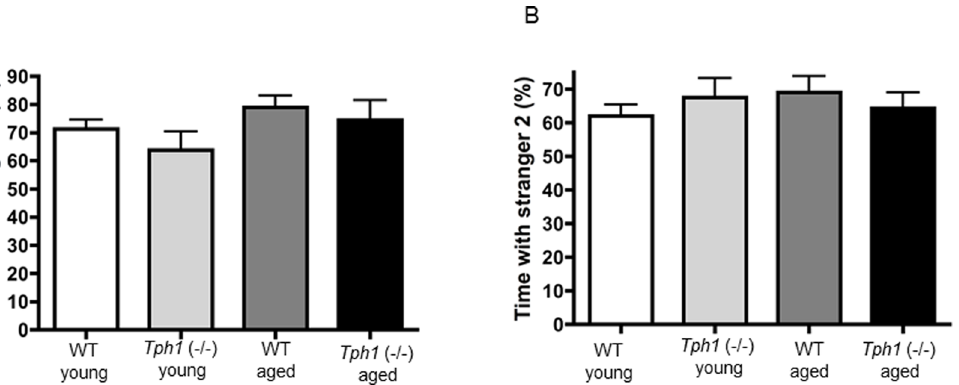
Figure 4. Tph1 ( 2 / 2 ) mice have a normal response to social novelty. Tph1 ( 2 / 2 ) mice demonstrate similar responses to a stranger mouse (A) and to a novel mouse (B). The percentage of time that the test mouse spent exploring stranger 1 was comparable to age-matched WT animals (A) and the time that the test mouse spent exploring stranger 2 was comparable to age-matched WT mice (B).